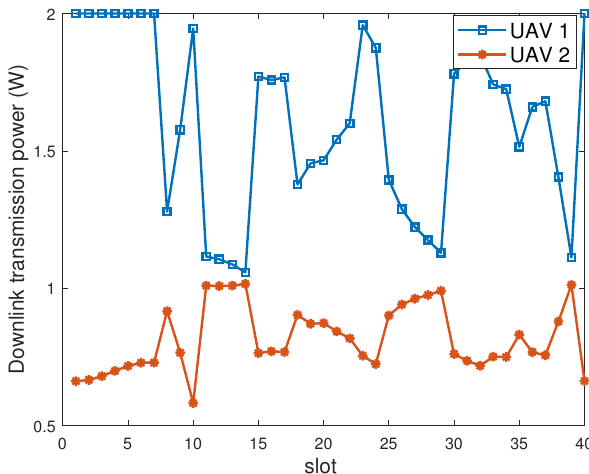
Figure 3. Optimized UAV downlink transmission